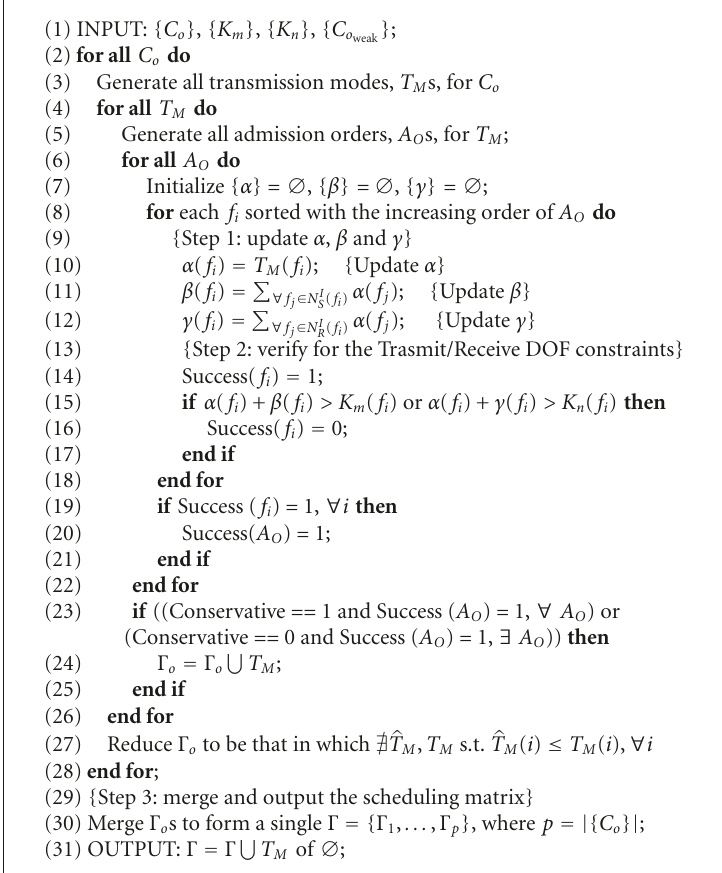
Algorithm 1: Transmission mode generating Algorithm 1